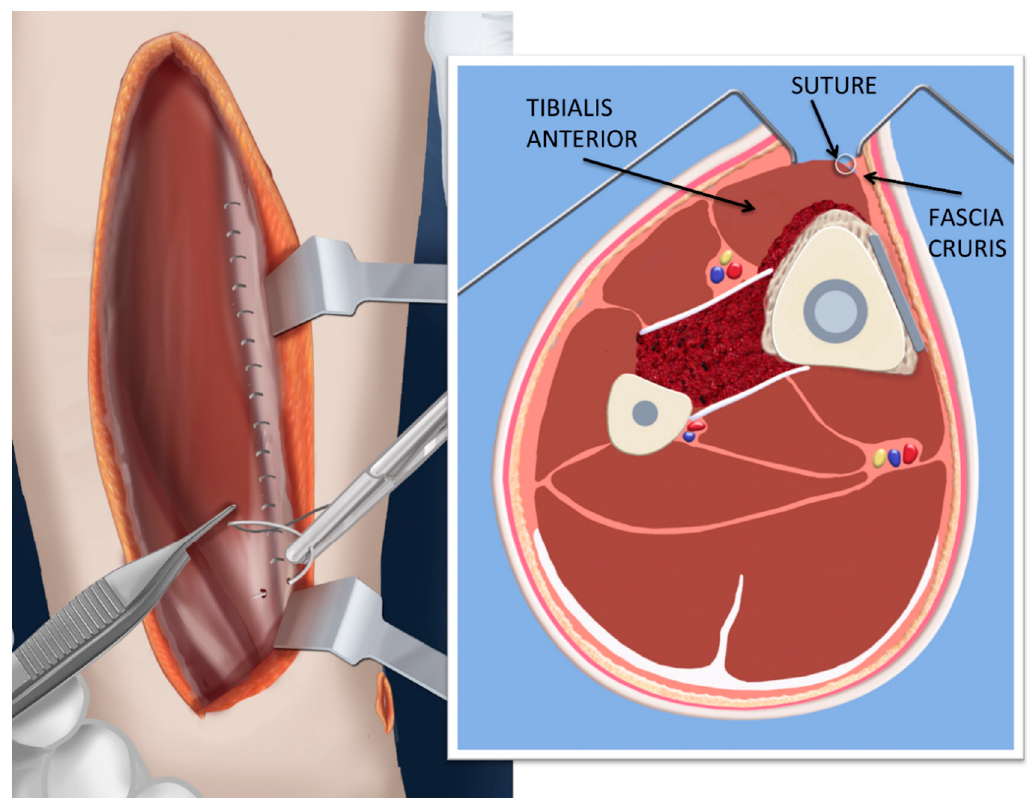
Figure 5. Illustration of the cross-sectional appearance of the cross-union. Note the BMP is the outermost layer with the bone graft contained between in the interosseous space. This allows the BMP to maintain contact with the vascularized soft tissues. The anterior compartment musculature is closed overtop.